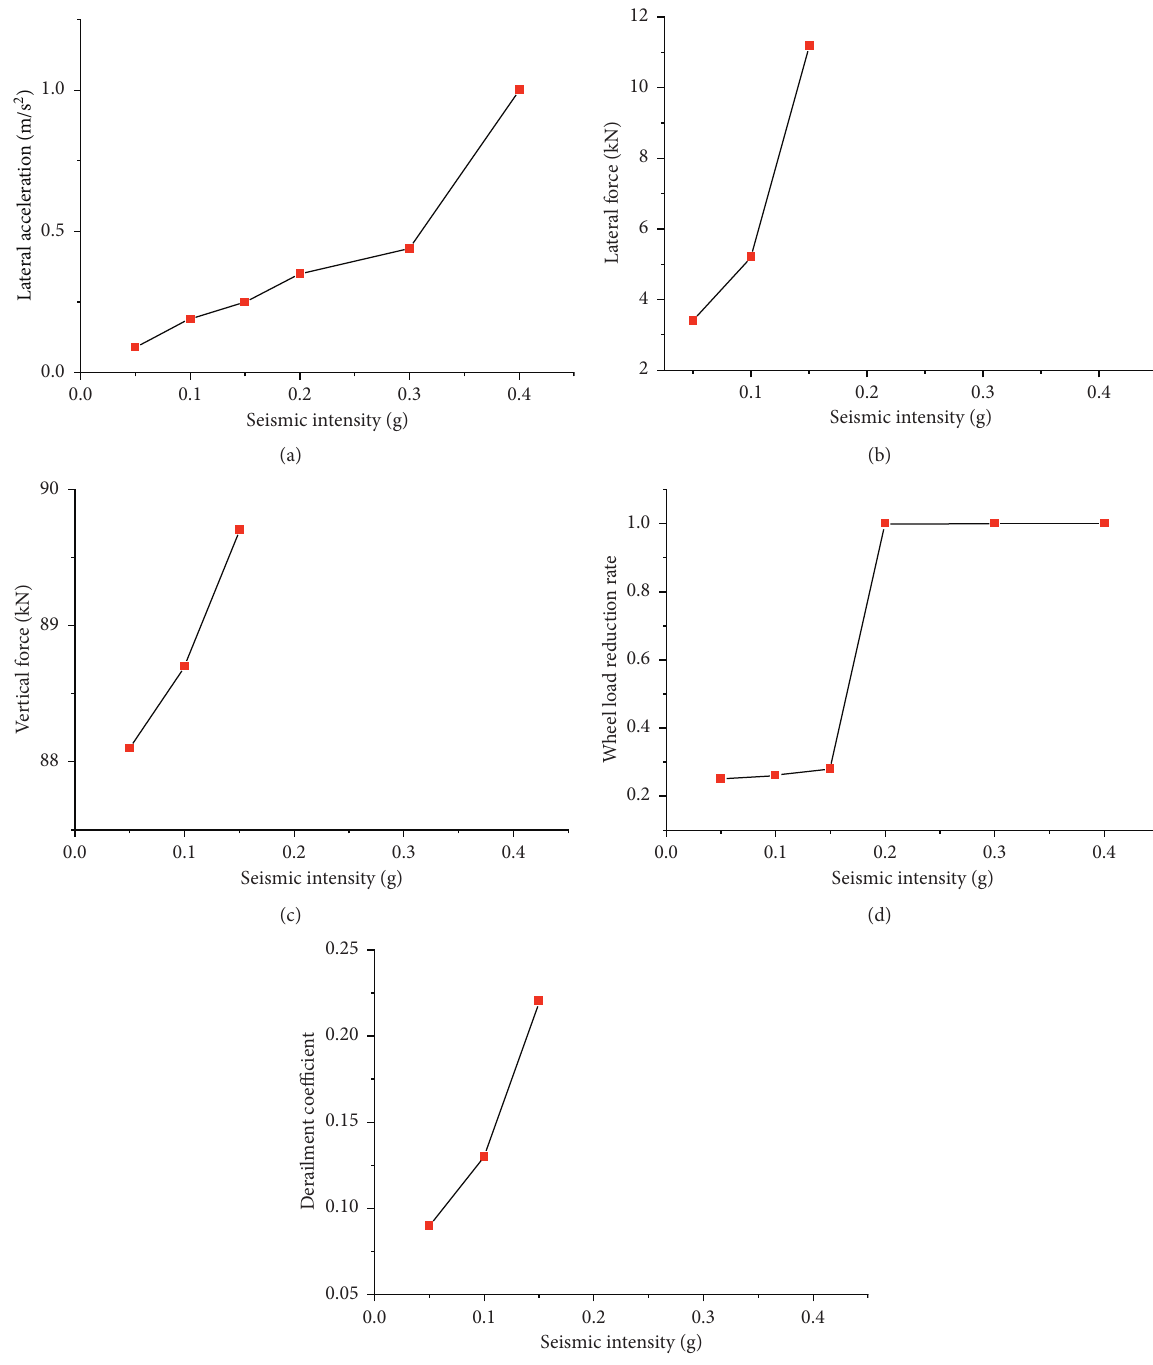
Figure 23: Changes in the dynamic response indexes under the Taft wave. (a) Changes in lateral acceleration. (b) Changes in lateral force. (c) Changes in vertical force. (d) Changes in wheel load reduction rate. (e) Changes in derailment